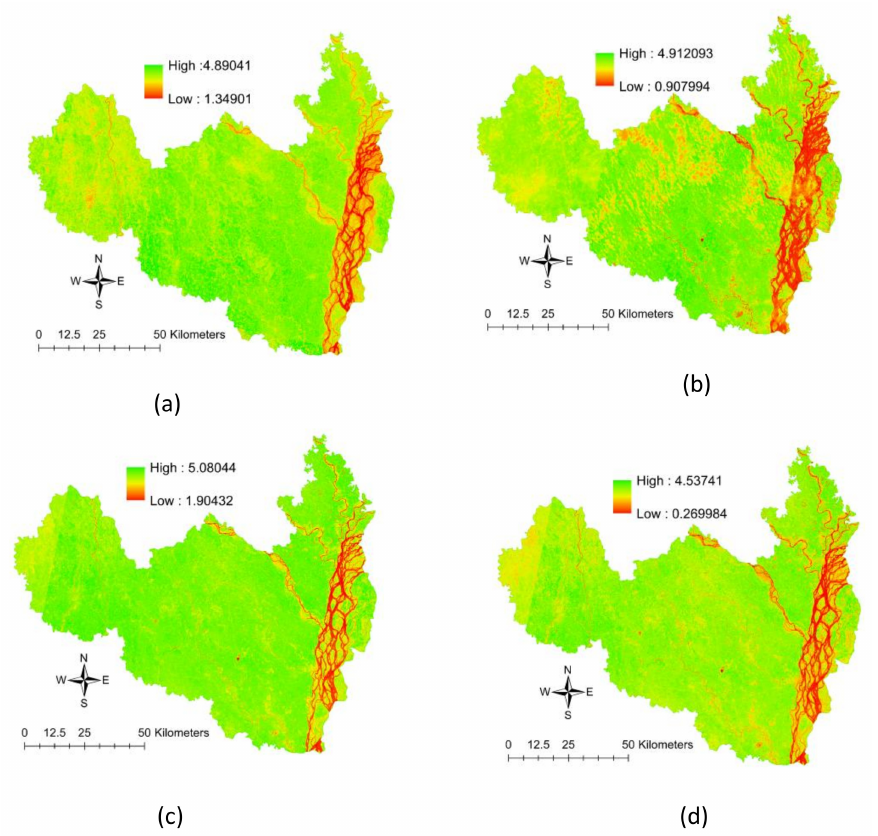
Figure 10. Yield prediction map (MT/ha) ( a ) 2017, ( b ) 2018, ( c ) 2019, ( d )